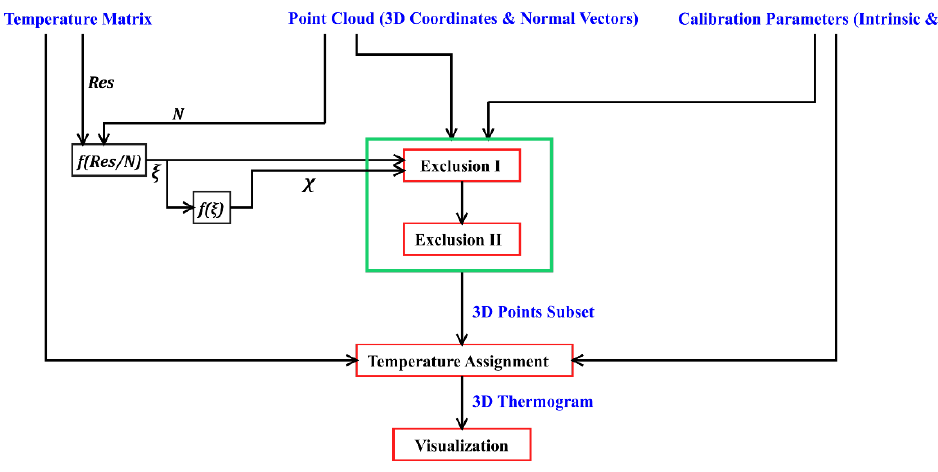
Figure 6. Overall workflow of the data fusion process.